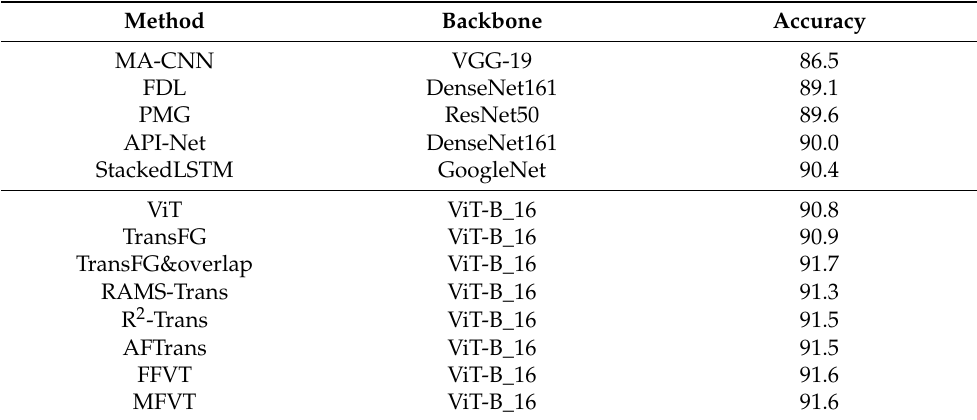
Table 8. Accuracy of different methods on CUB-200-2011.